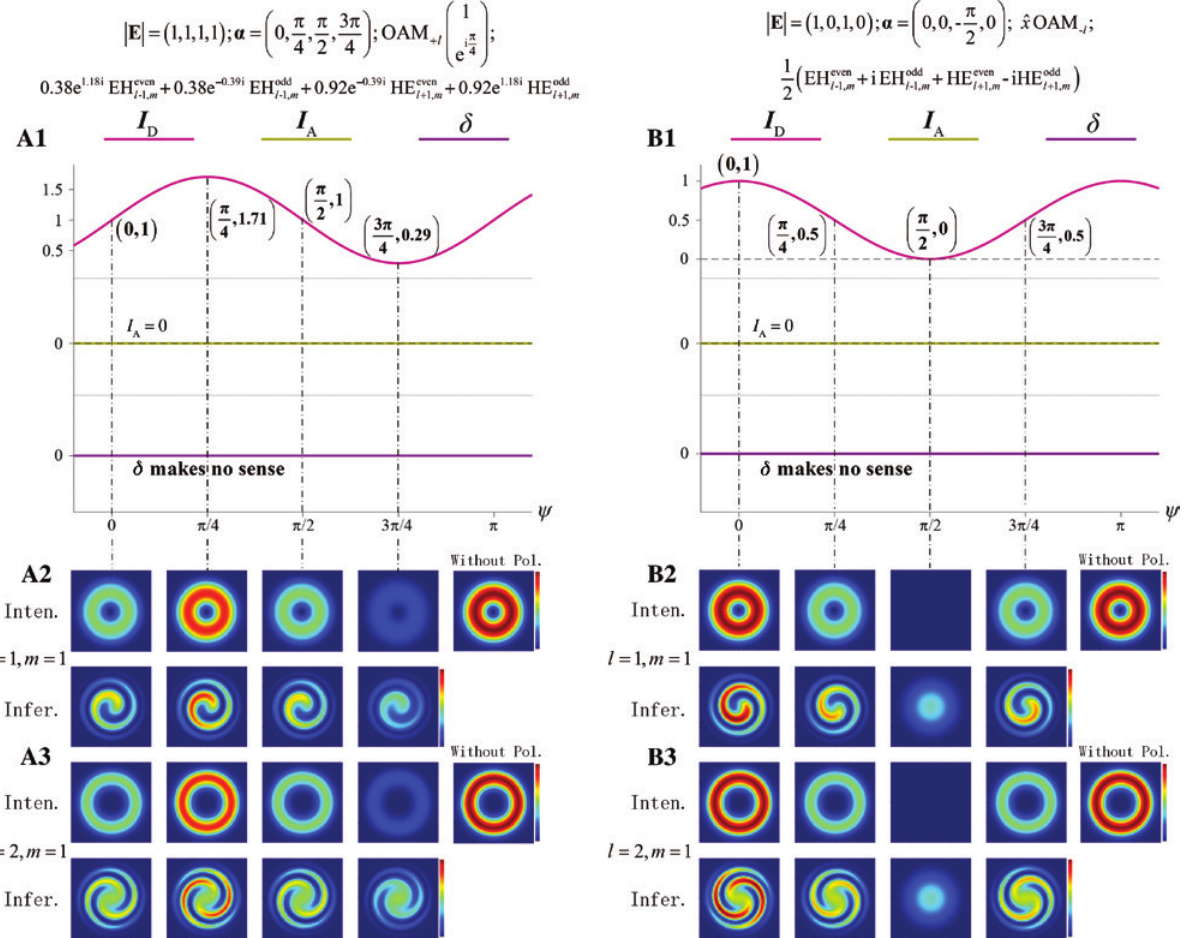
Figure 7: Corresponding relation between the expanded Jones model and mode patterns of an elliptically polarized OAM mode and a circular polarized OAM